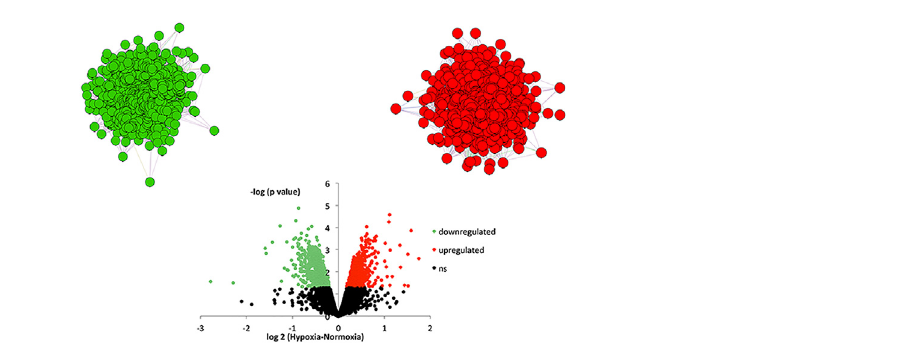
on the basis of “ genetic interaction ” alone also included most of the upregulated (n = 520) and downregulated (n = 694) genes (Table 1).